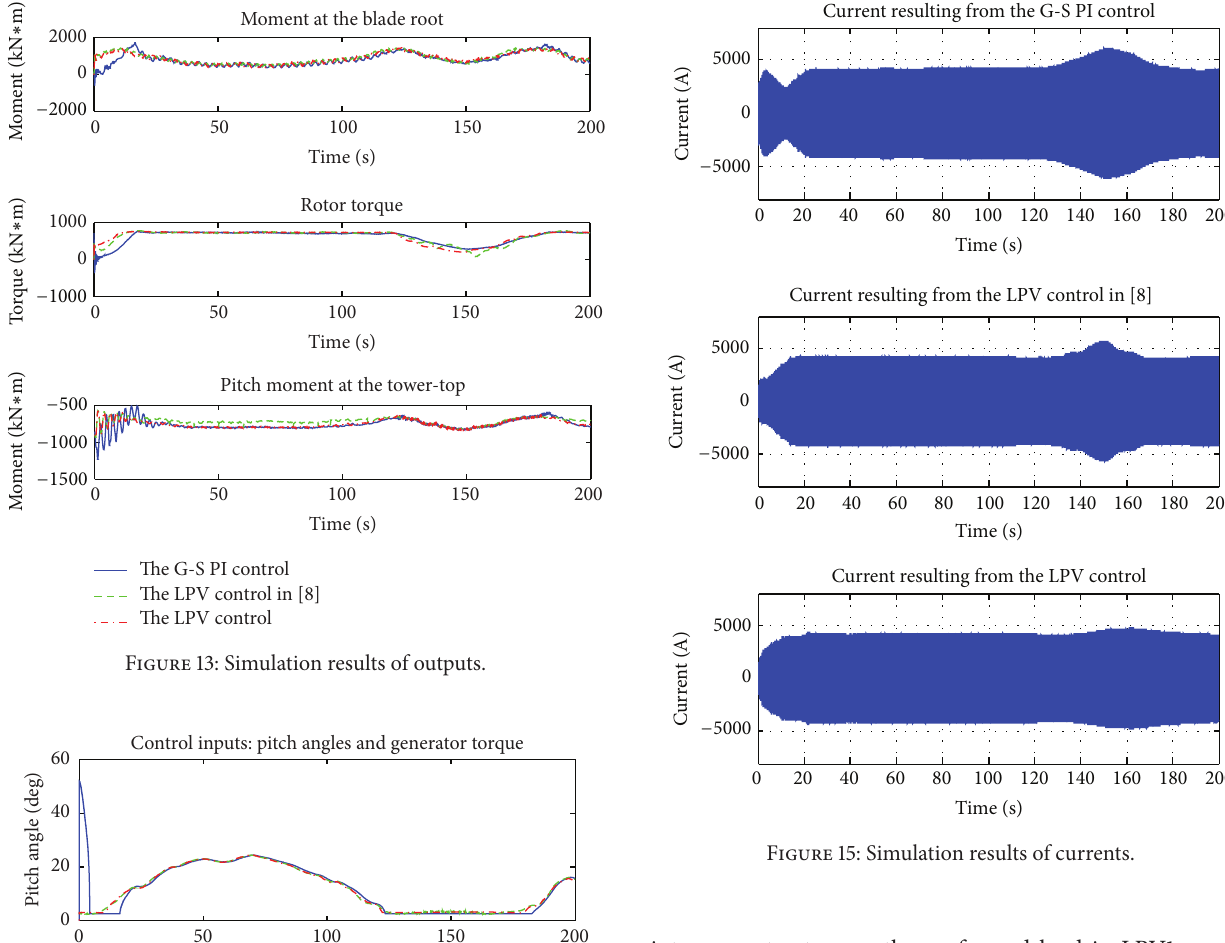
Figure 15: Simulation results of